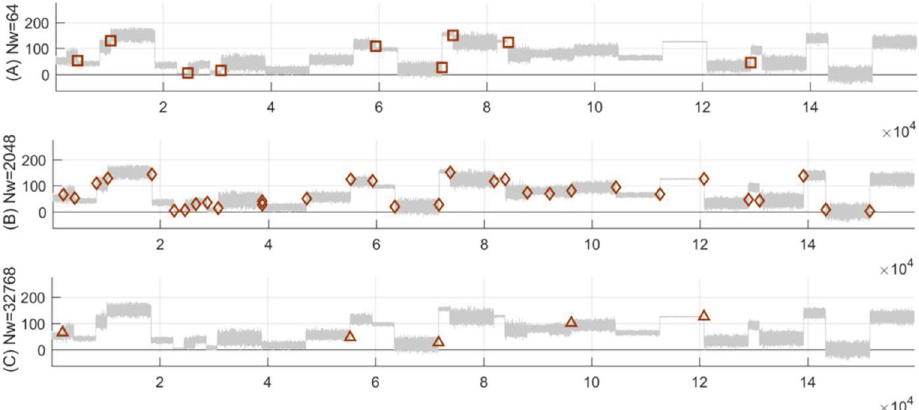
Fig 6. The selected simulations of MCPs detection as Nw taking a suitable, smaller or larger value in the FSW framework. Given the similar sample with predefined 30 t MCPs used in Fig 5, the results of MCPs detection by using TST method are presented as (A) Nw = 2^6, (B) Nw = 2^11 and (C) Nw = 2^15 respectively.